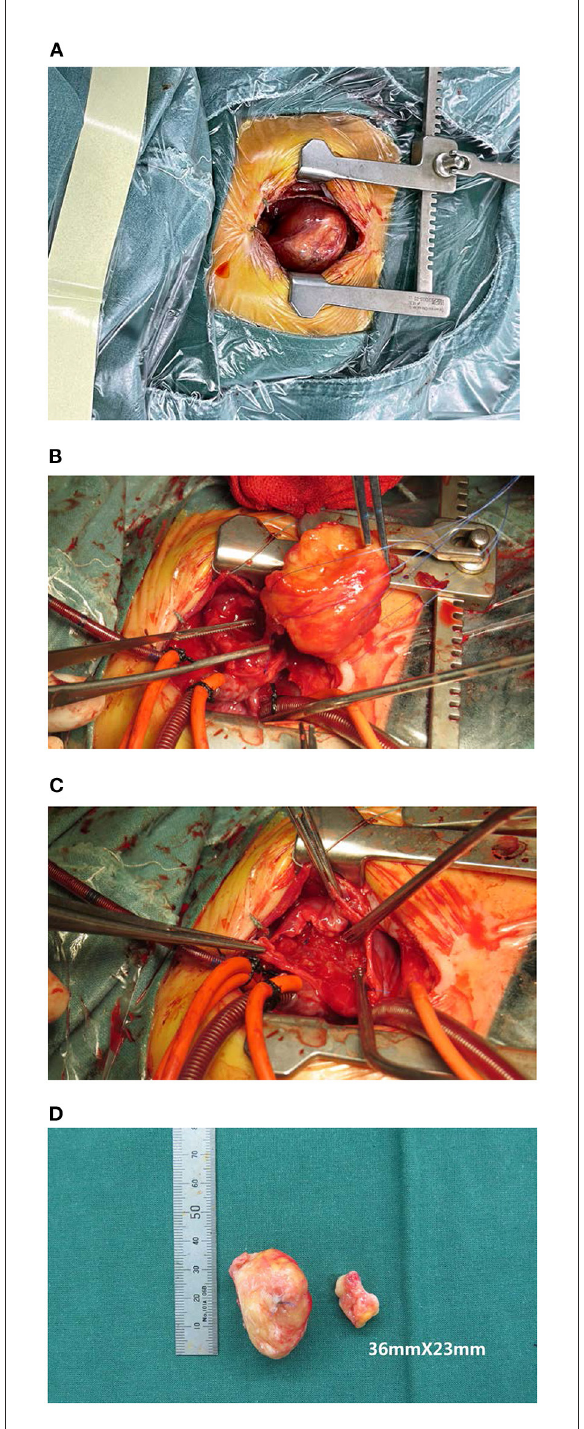
FIGURE3 (A) Tumor appearance before an operation; (B) Removal of a tumor; (C) During operation, right ventricular wall wound after tumor removal; (D) Tumor specimen appearance.